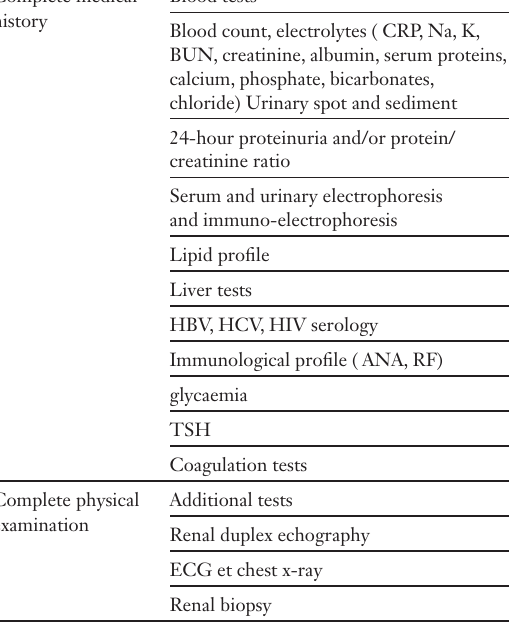
Initial evaluation of nephrotic patients (except